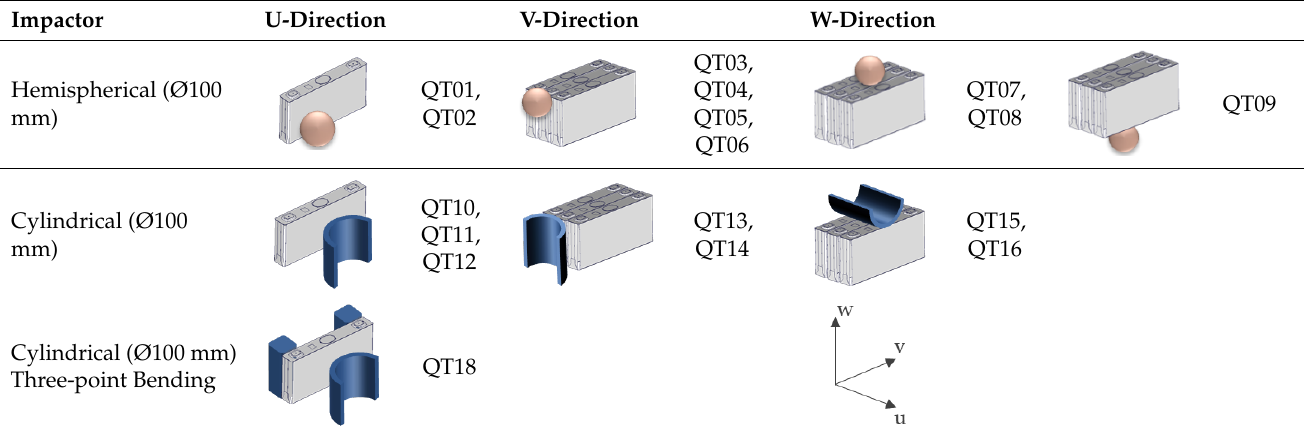
Table 1. Test configuration in u-, v-, and w-directions.